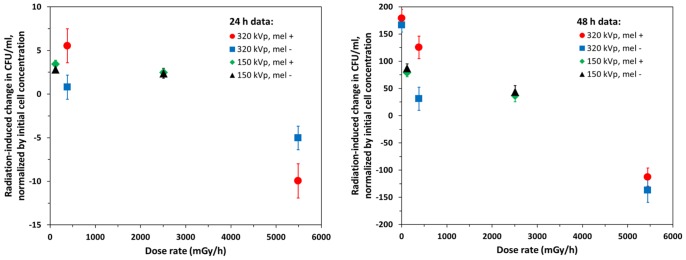
Effects of 24 and 48 hours of continuous X-ray irradiation on the proliferation of C. neoformans.The symbols represent mean values of the radiation-induced change (Qe) in CFU/ml (normalized by the initial cell concentration) for the same X-ray dose rate categories as in Table 1, plotted as function of mean dose rate for each category. Error bars represent standard errors. The abbreviations “mel +” and “mel –” represent melanized and non-melanized cells, respectively.